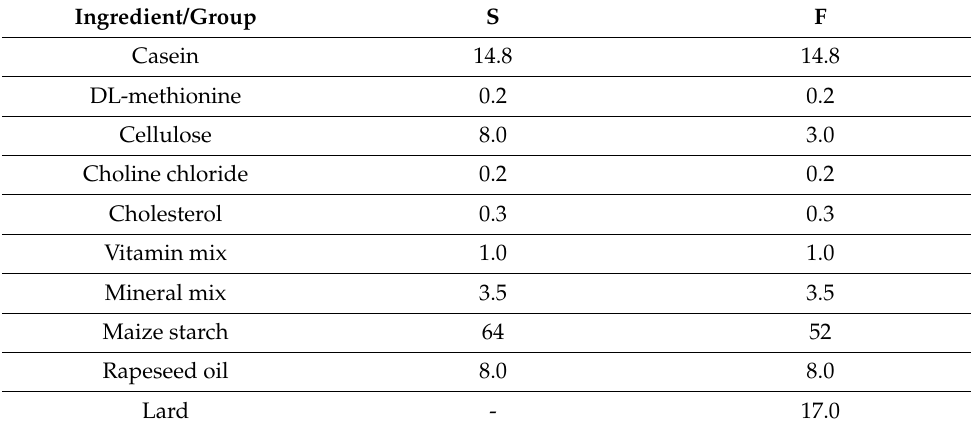
Table 1. Composition of diets fed to rats (%)